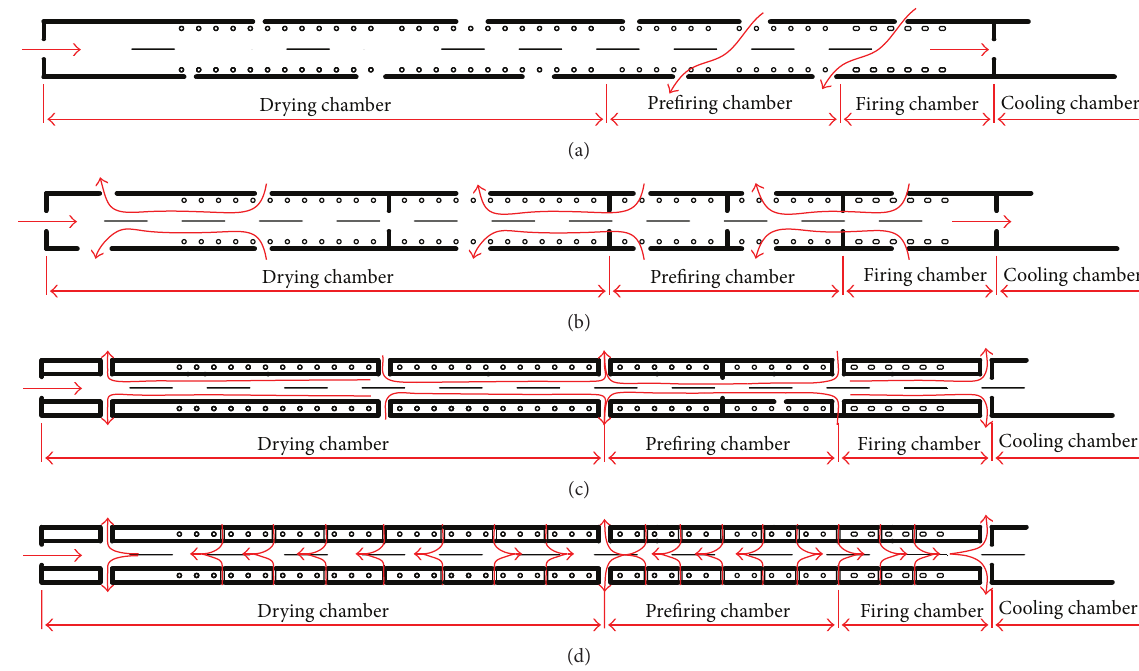
Figure 5: The longitudinal section model of the firing furnace.